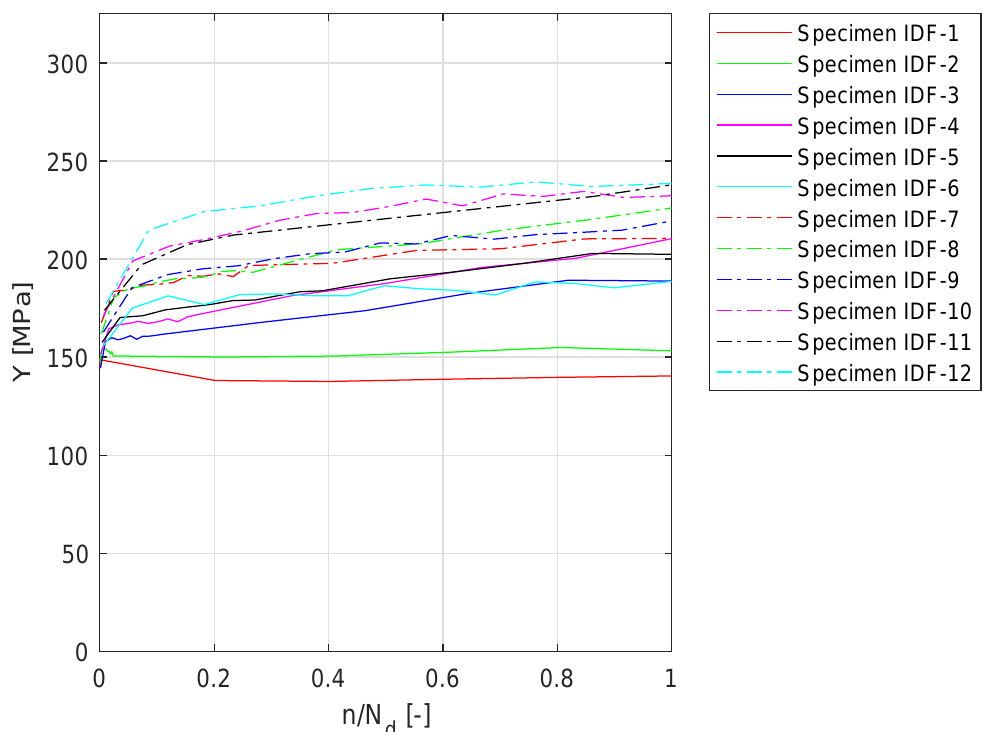
Figure 11. Actual yield stress development during fatigue life evaluated for 08Ch18N10T.